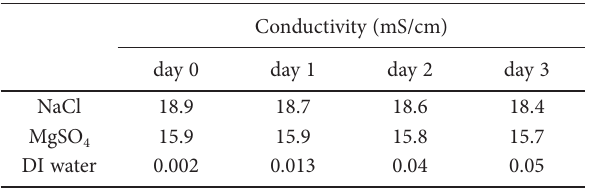
Table 6. Electrical conductivity results for 0.2 M salt solutions (Conductivity in solution) with experimental error ± 0.05 mS/cm.